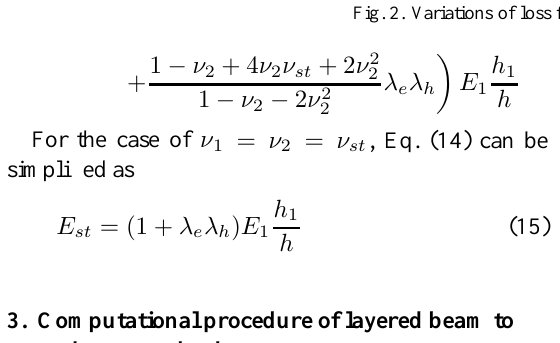
Fig. 2. Variations of loss factor ratio with thickness